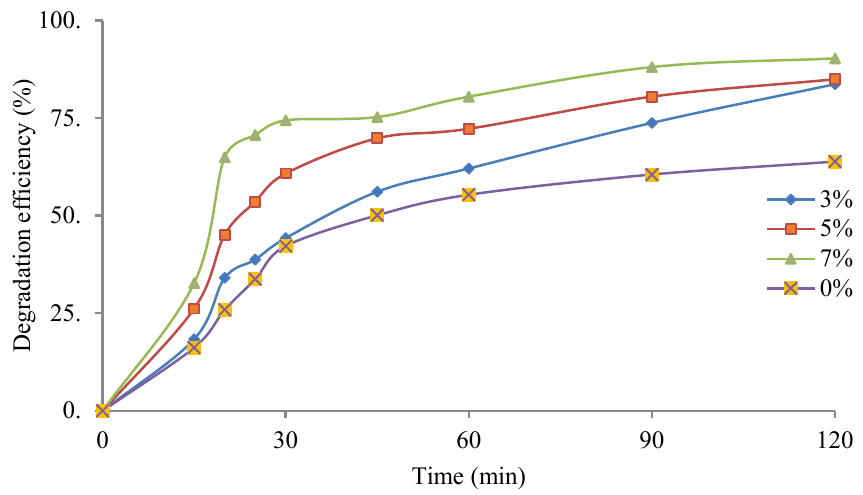
Fig. 6. The photocatalytic performance of pure and Sn-doped TiO